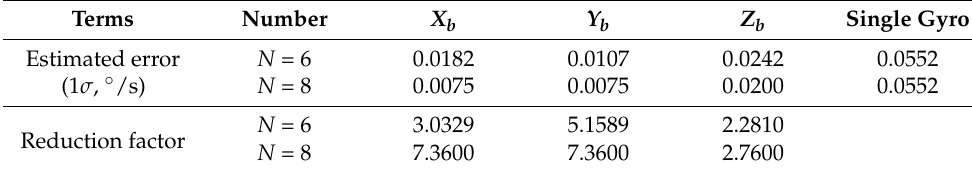
Table 6. The estimated error of 6- and 8-gyro MIMU systems for scheme 2.